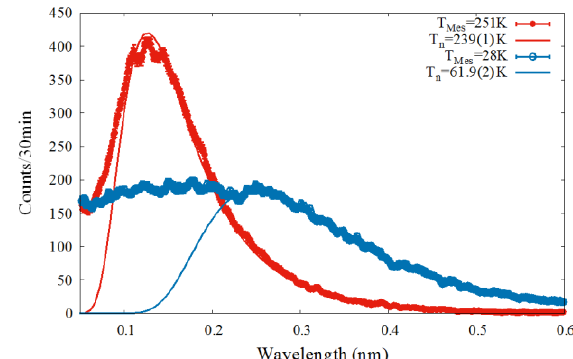
Fig. 4. Examples of Maxwellian fit to neutron TOF data shown in Fig.2 in the 251K (red) and 28K (blue) case.